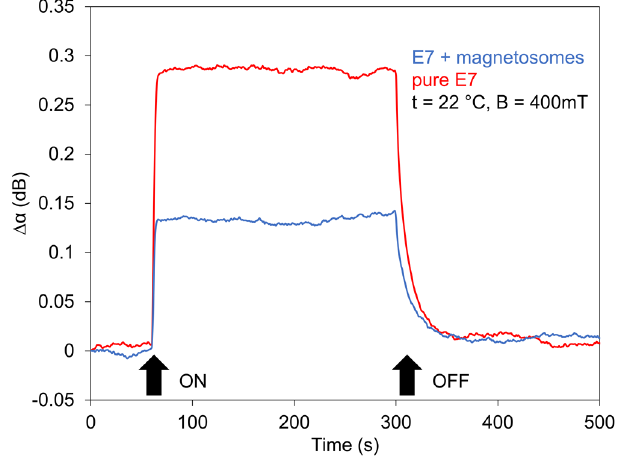
Figure 11. Effect of jumped magnetic field (400 mT) on SAW attenuation of E7 doped with magnetosomes (0.2 wt%) compared with pure LC.